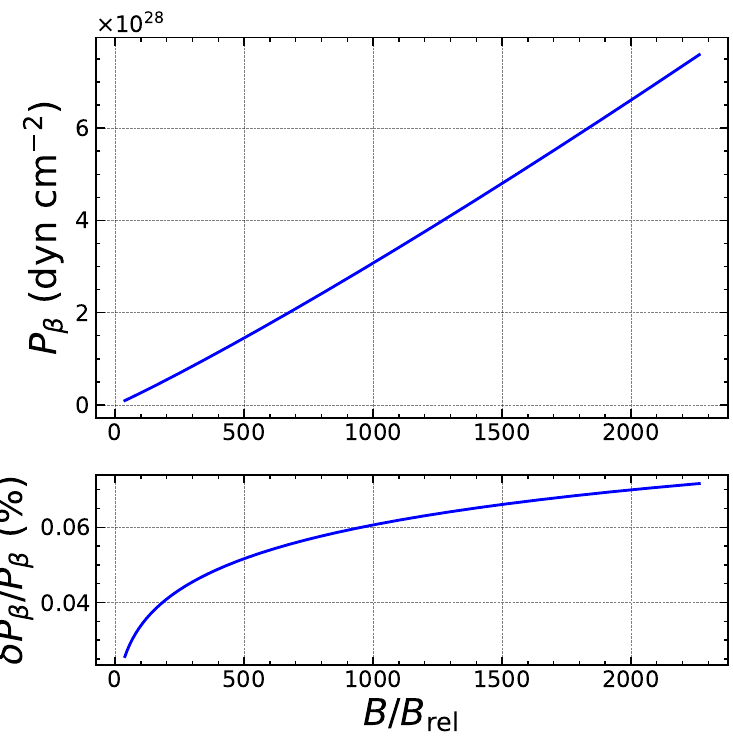
Figure 6. Same as Figure 5 in the strongly quantizing regime.